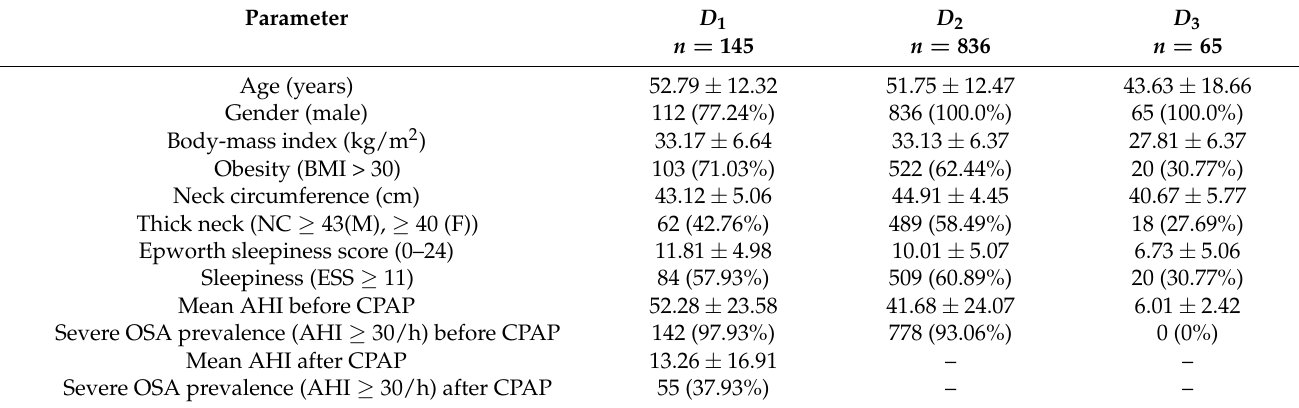
Table 1. Anthropometric patient data and clinical parameters of the study cohorts: CPAP treatment group D 1 ( n = 145), OSA-diagnosed group D 2 ( n = 836), and non-OSA control group D 3 ( n = 65). We provide the results as either average ± SD or number and percentage n (% n ). Patients in D 2 and D 3 did not undergo CPAP